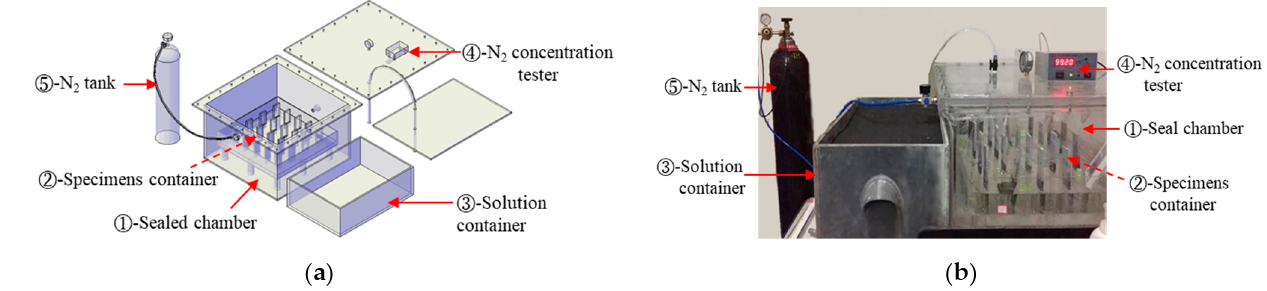
Figure 1. Experimental setup. ( a ) Schematic diagram ( b ) Experimental